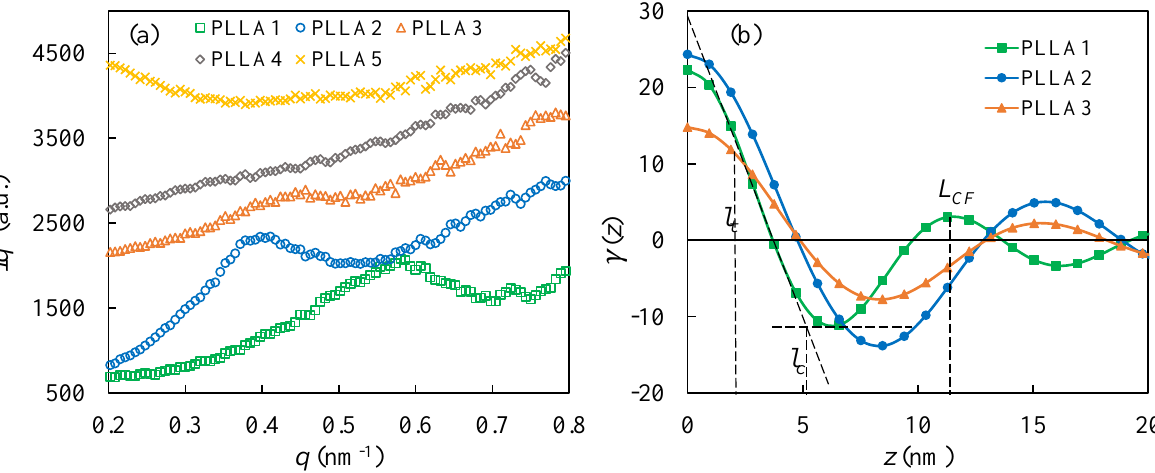
Figure 6. SAXS measurement results of crystallized PLLA samples after crystallization treatment at 80 °C: ( a ) Lorentz-corrected SAXS profiles; ( b ) one-dimensional correlation function profiles of PLLA1, PLLA2 and PLLA3 samples. The correlation function long periods ( L CF ), crystal thicknesses ( l c ) and transition region thicknesses ( l t ) are marked on PLLA 1′ s curve as an example.